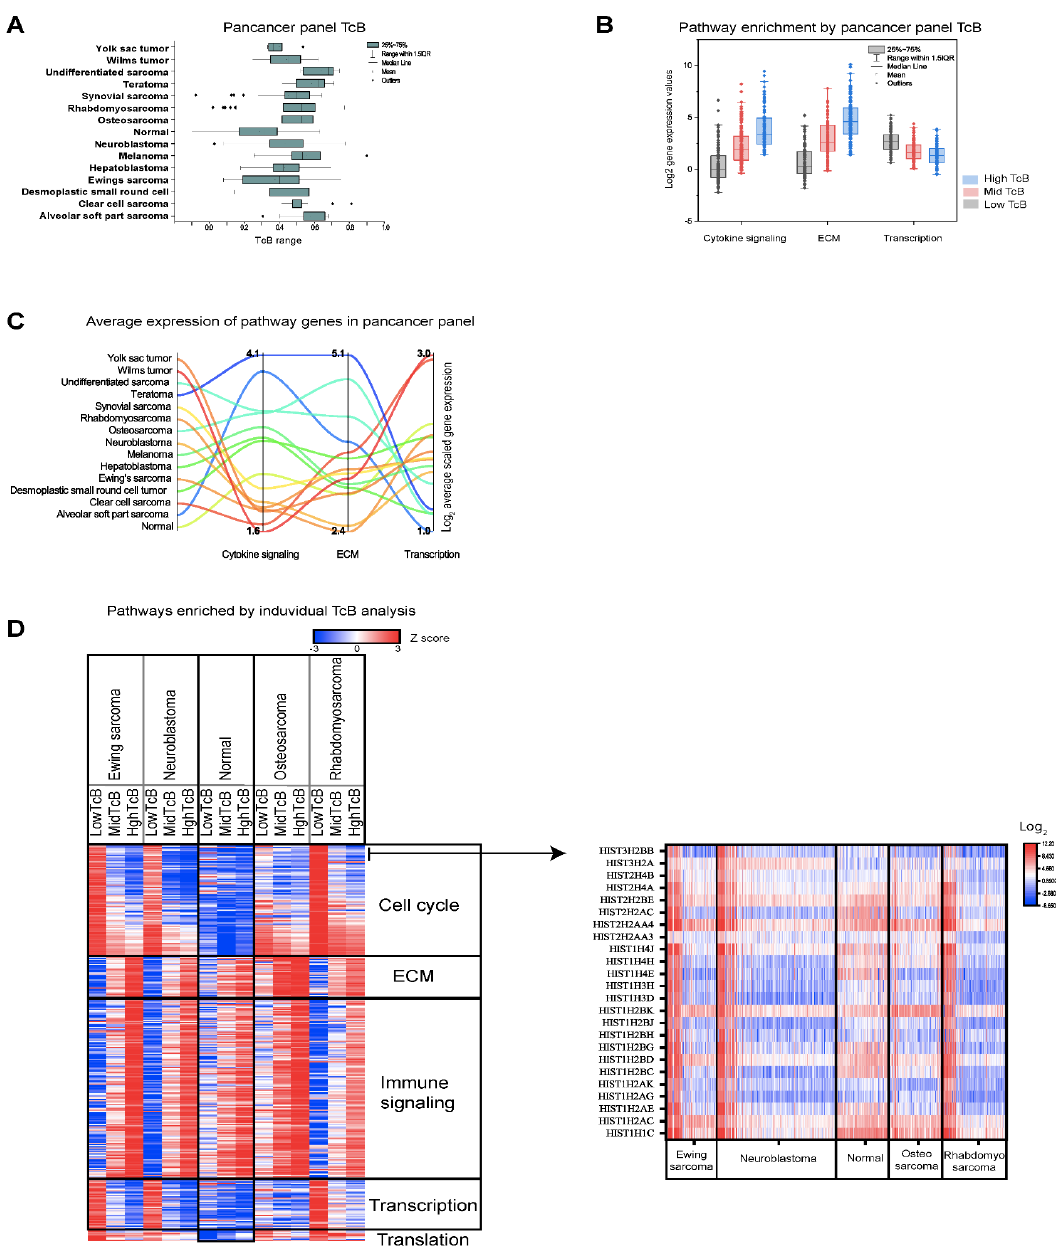
Figure 4. Biological progression patterns in pediatric extracranial solid tumor and normal tissue panel. ( A ) Bar graph represents values calculated from a transcriptomic dataset consisting of multiple pediatric solid tumors ( y -axis) show that median TcB values ( x -axis) of tumors are higher than normal tissues. ( B ) Bar graph illustrates median log 2 expression levels ( y -axis) of genes representing higher order processes ( x -axis) determined from a pan pediatric solid tumor and normal tissue panel. ( C ) Summary of gene-expression differences between tumors and normal tissues (median log 2 ), representing changes in higher-order processes. ( D ) Heatmap of higher-order biological processes enriched by independent TcB calculations based on the tumor or normal tissue type indicates unique biological properties are observable in tumors. An arrow points to the heatmap (right), which reveals that declines in histone complex gene expression as correlating feature in changes observed with cell cycle gene expression with TcB